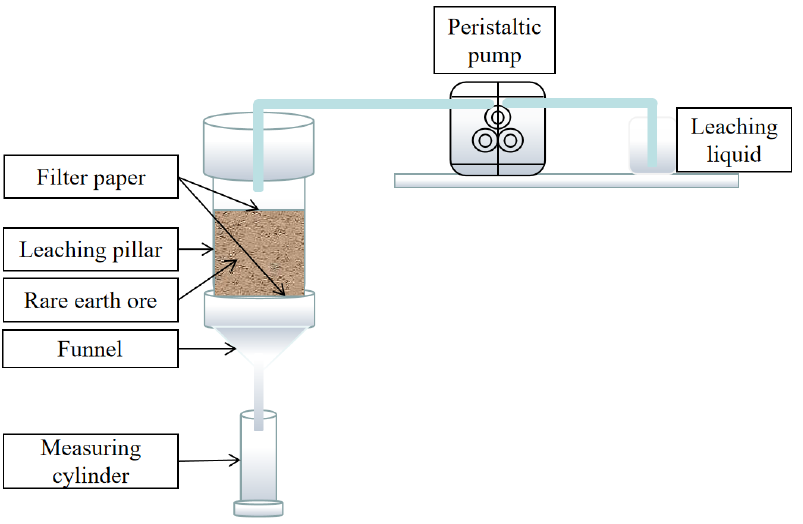
Figure 2. Indoor column immersion experimental